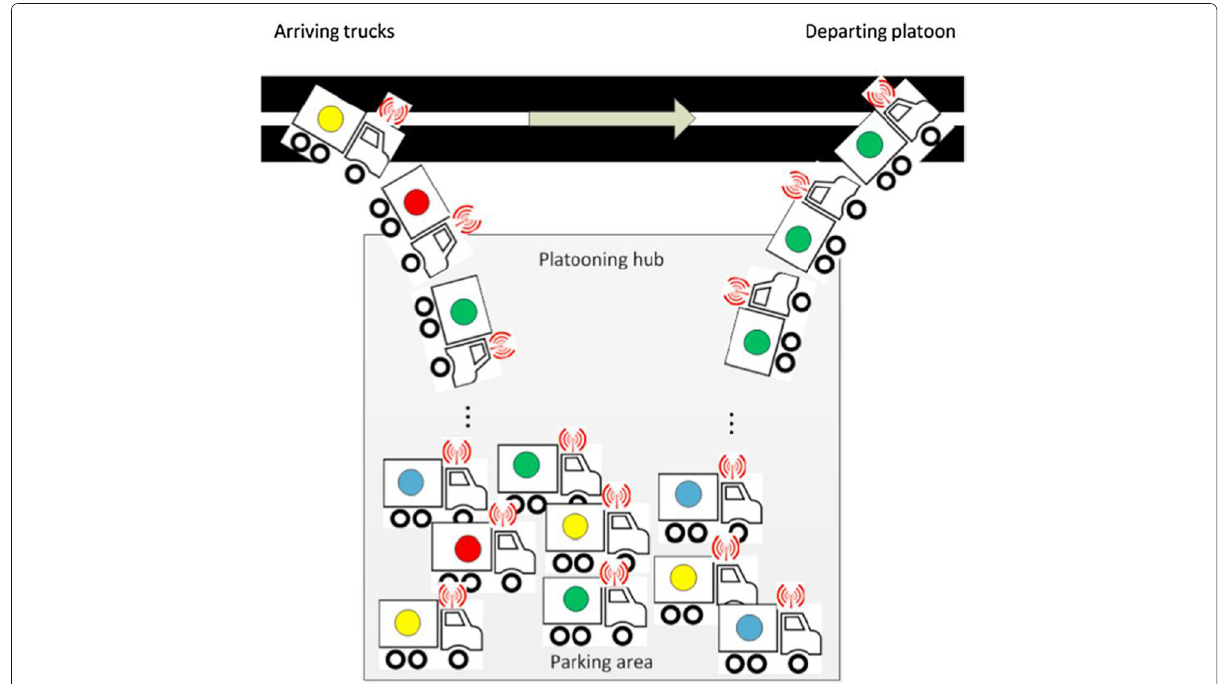
Fig. 1 Platooning hub